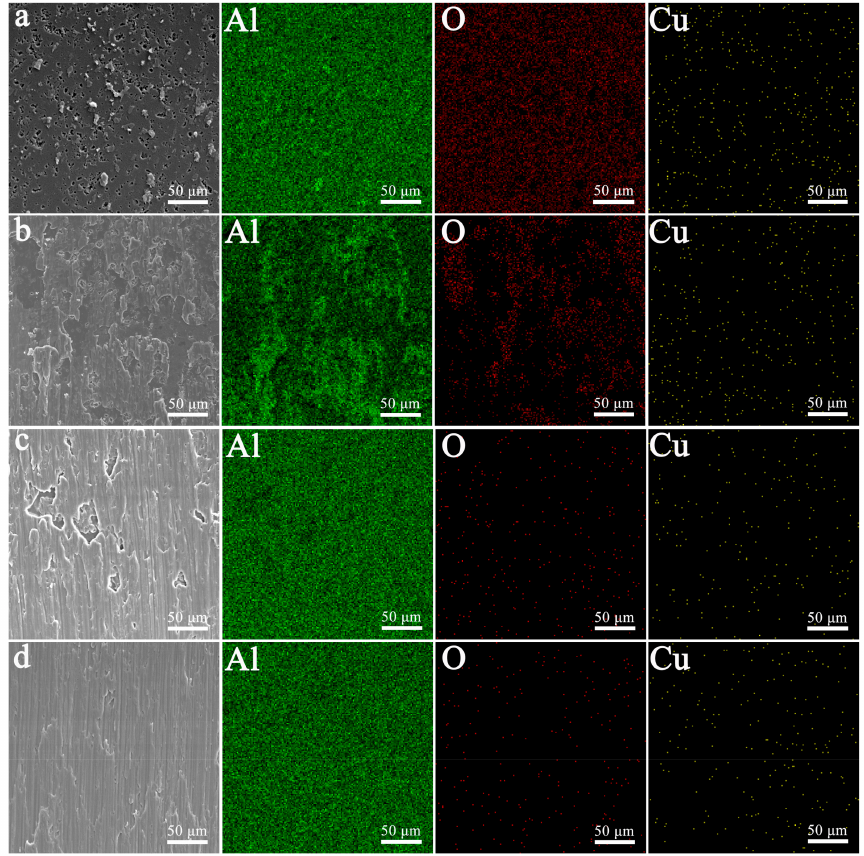
Figure 9. The area-scanning results of the Al, O, and Cu elements of the brazing fractures of the two kinds of sample. Without the Al film deposited sample: ( a ) 700 ◦ C; ( b ) 800 ◦ C; ( c ) 900 ◦ C; with Al film deposited: ( d ) 700 ◦